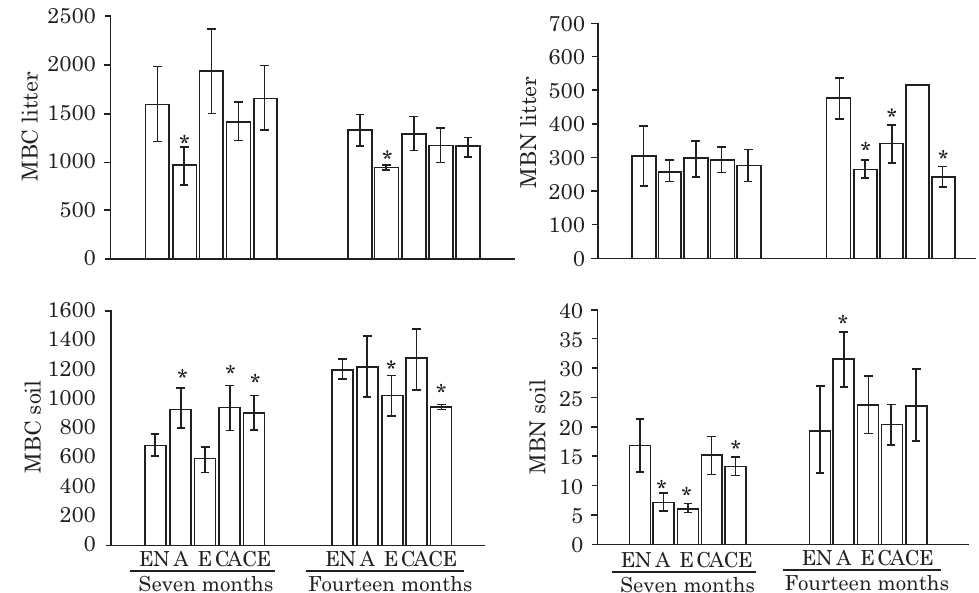
Figure 2. Microbial biomass carbon (MBC) and nitrogen (MBN) of soil and litter seven and 14 months after planting. (A) A. mangium monoculture; (E) E. grandis monoculture; (EN) E. grandis monoculture with N fertilizer; (CA) mixed plantation (at the stem base of A. mangium ); (CE) mixed plantation (at the stem base of E. grandis ). (*) indicate a statistical difference from the EN treatment according to Duncan’s test at a 5